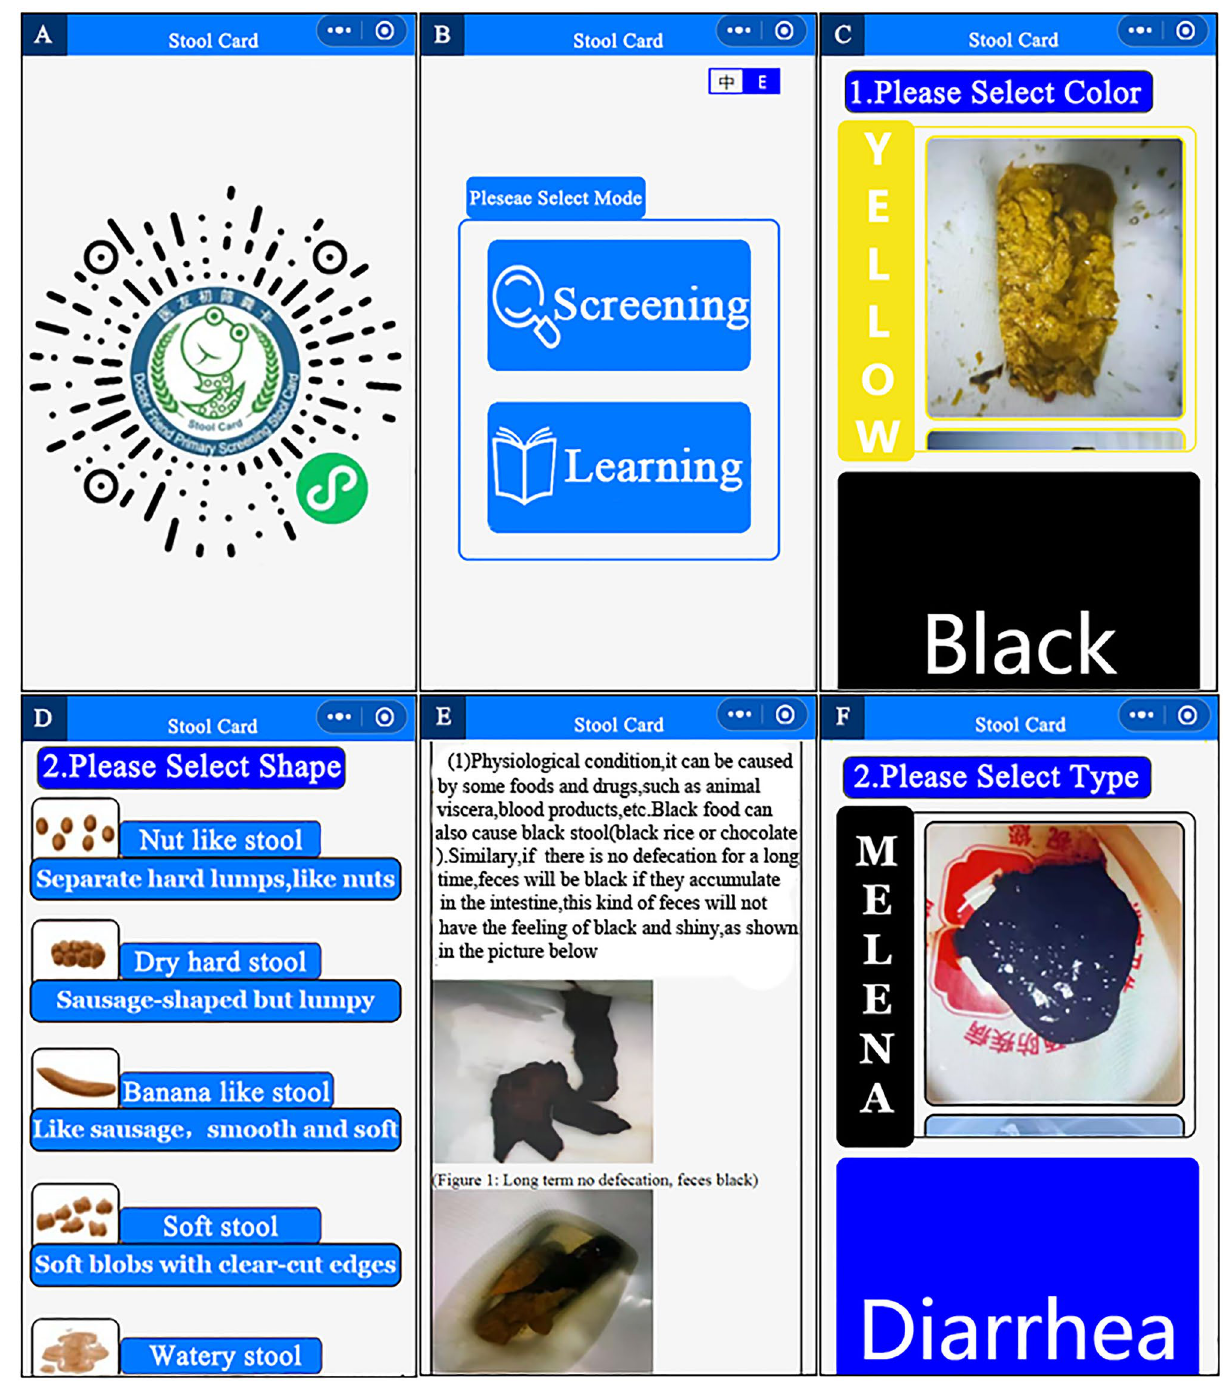
Figure 1. Interface display of Doctor Friend Primary Screening Stool Card. ( A ) QR code display of applet. ( B ) Mode selection interface. ( C ) Screening mode—color selection interface. ( D ) Screening mode—shape selection interface. ( E ) Fecal information display interface. ( F ) Learning mode